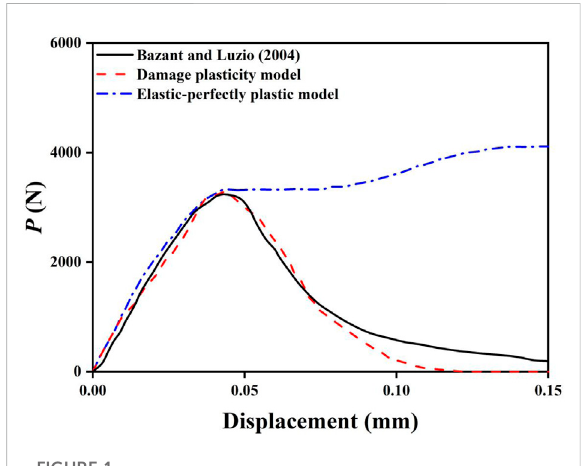
FIGURE 1 Load (P) – displacement curve from Zheng et al.